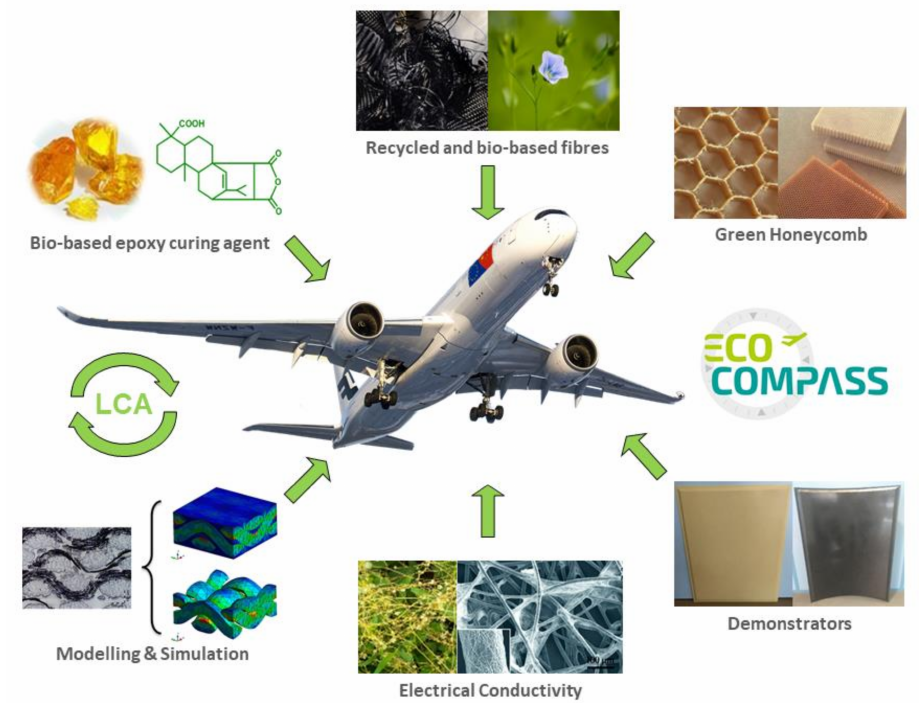
Figure 1. Examples of the materials and technologies developed during the ECO-COMPASS EU/China